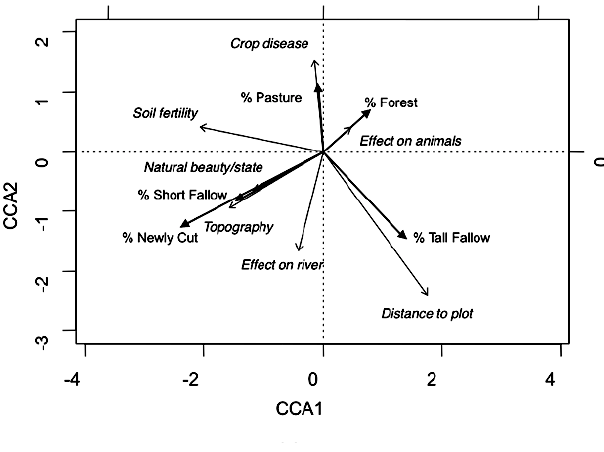
Fig. 5 . Biplot of canonical correspondence analysis between land cover and ecological perceptions of influences on land use, as mentioned by interviewees. Ecological explanatory variables are in italics, while percent land cover dependent variables are represented by bold arrows. Soil characteristics includes the soil fertility and water content of the soil.